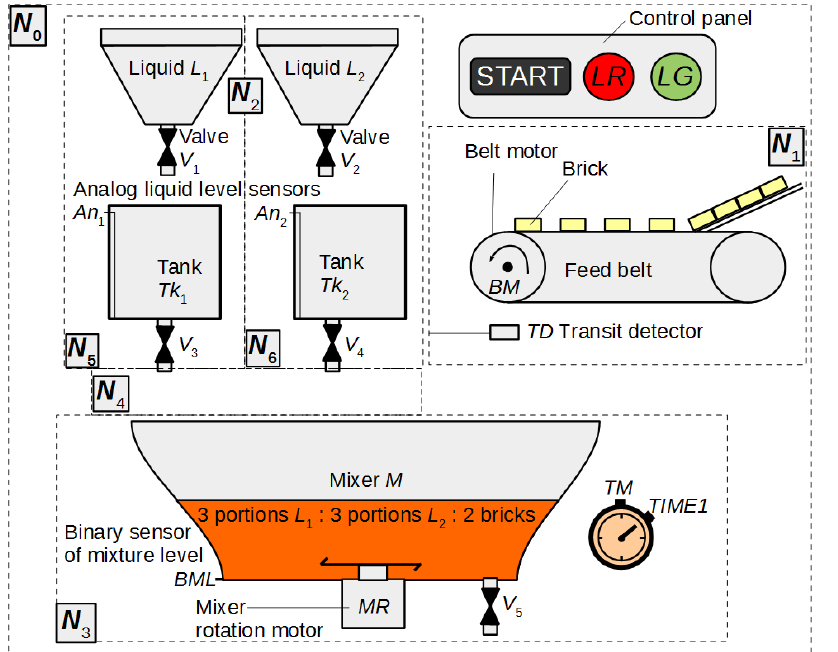
Figure 11. The scheme of the system to mix three components: two liquids and soluble bricks. Based on [64].